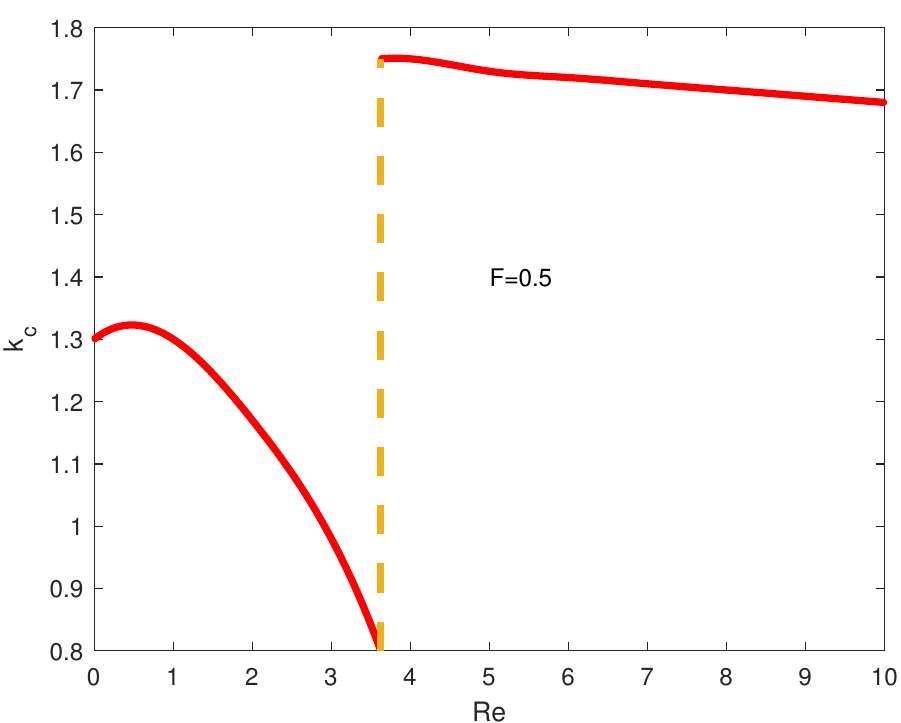
Figure 8. Critical Grashof numbers versus Re for F = 0.5. Figure 9 plots the critical Grashof numbers versus positive and negative values of Re in the range − 8 ≤ Re ≤ 8 for four different values of the Frank–Kamenetskii parameter F , namely, F = 0.1, 0.3, 0.5 and 0.7. The values of R and Pr are fixed at η = 0.6 and Pr = 2, respectively. Several conclusions can be drawn from the graphs in Figure 9. First, both inward and outward radial flows (negative and positive Reynolds numbers) have a stabilizing influence on the stability boundary. Second, for each F , three different intervals characterizing the rate of increase in the Grashof number with respect to Re can be identified. The first interval (approximately from Re = − 2 to Re = 3.6) is associated with relatively strong stabilization of the base flow. The second interval ( Re > 3.6) appears right after the transition to a larger wave number takes place (see Figures 4 and 5 for details). The critical Grashof numbers continue to grow, but at a lower rate. However, as Re increases further, stabilization becomes stronger (the rate of increase in Gr c with respect to Re increases). A similar situation takes place around the value Re = − 2. Here, again, transition to a larger wave number takes place. As a result, the rate of growth of Gr c with respect to Re decreases, but then increases again as the Reynolds number becomes more and more negative. Third, the rate of increase in Gr c with respect to Re is not the same for positive and negative Reynolds numbers. Fourth, base flow stabilization also depends on the value of the Frank–Kamenetskii parameter F . Stabilization is much stronger for small F (see the graph for F = 0.1 in Figure 9) and less pronounced for larger F . Fifth, as F increases, the critical Grashof number approaches zero. The last conclusion is consistent with the fact that a steady convective flow in the vertical direction generated by internal heat sources exists only in the range 0 < F < F ∗ (see [10] for the case Re = 0), where F ∗ depends on R and Re , and there is no steady solution for F > F ∗